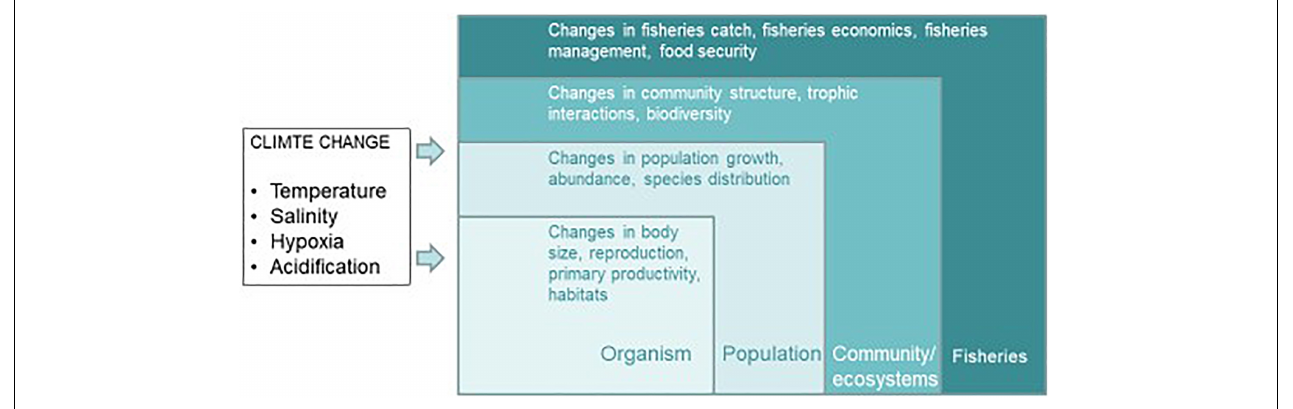
FIGURE 2 | Climate change impacts on marine ecosystems and goods and services provided to human society. Figure adopted from Sumaila et al. (2019).